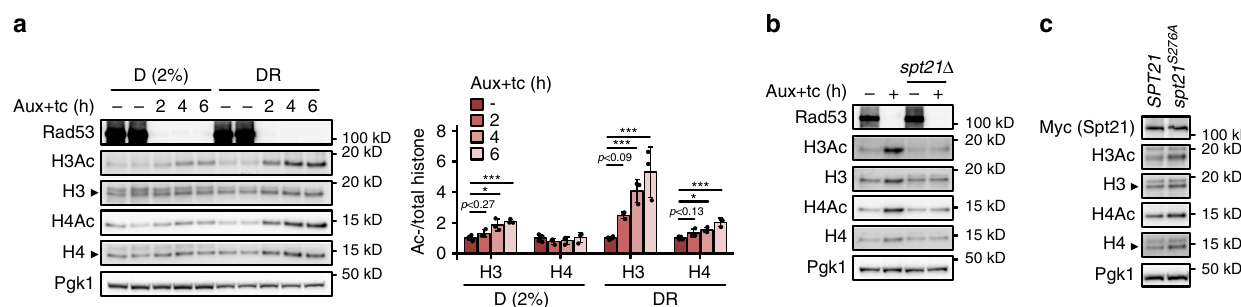
Fig. 5 Excess histones are hyperacetylated. a Rad53-AID cells were adapted to normal or low glucose, Rad53 depletion was induced by addition of Auxin and tetracycline, and samples were collected at the indicated times to detect Rad53 and modi fi ed histones by western blot analysis ( N = 3 replicates). The bar chart (right panel) provides a quanti fi cation of histone acetylation normalized by total histone levels. Signi fi cances were calculated with one-way ANOVA ( p D_AcH3 = 9.4 × 10 − 5 , p DR_AcH3 = 4.0 × 10 − 5 , p DR_AcH4 = 7.4 × 10 − 5 ) with post hoc Tukey HSD test ( p D_AcH3_2h_vs_UT = 0.26, p D_AcH3_4h_vs_UT = 0.0010, p D_AcH3_6h_vs_UT = 0.00013, p DR_AcH3_2h_vs_UT = 0.081, p DR_AcH3_4h_vs_UT = 0.00081, p DR_AcH3_6h_vs_UT = 0.000041, p DR_AcH4_2h_vs_UT = 0.12, p = 0.010, p = 0.000043). b Rad53-AID cells with the indicated SPT21 genotype were adapted to low glucose and treated DR_AcH4_2h_vs_UT DR_AcH4_2h_vs_UT as indicated with Auxin and tetracycline for 4h to deplete Rad53. Samples were collected to detect modi fi ed histones by western blot analysis. c Spt21-AID and Spt21 S276A -AID cells were adapted to low glucose and Auxin for 16 h. Auxin was washed away to stabilize Spt21 and samples were collected after 6 h to quantify proteins by western blot analysis. Bars plots with error bars represent mean values and standard deviation, D glucose; DR glucose restriction (0.02% in liquid media); Aux Auxin; tc tetracycline. * p < 0.05, *** p <